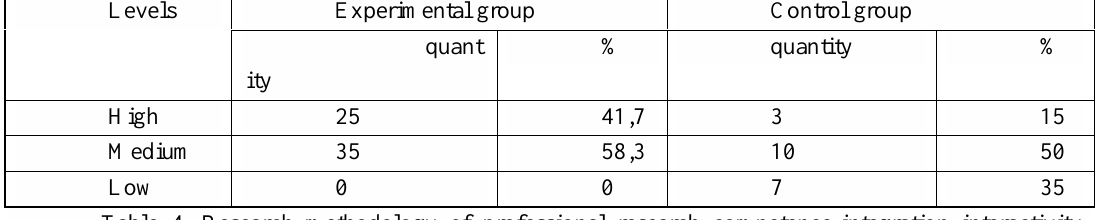
Table 4. Research methodology of professional research competence-integration interactivity. Level of research competence and integration